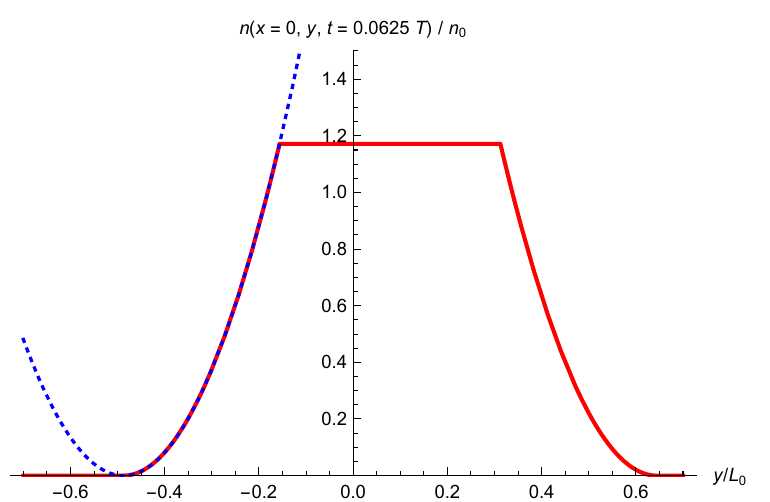
Figure 2: The shock wave theory (blue, dashed) vs exact hydrodynamics (red). The density is plotted at t = T / 16, along the vertical symmetry axis of the